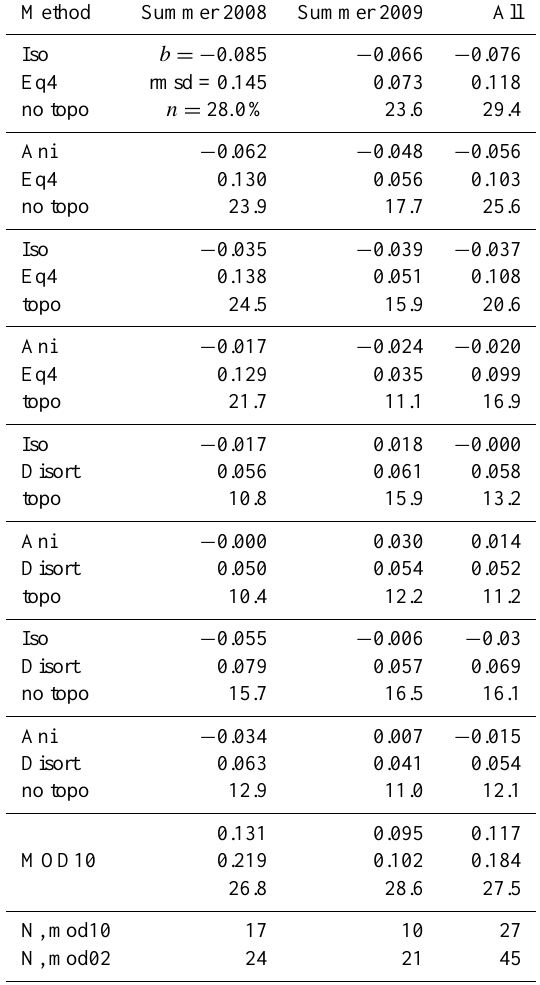
Table 4. Comparison between albedo values retrieved from MODIS and field measured albedo values for summers 2008 and 2009. In the methods, “Iso” means that snow and ice were considered as lambertian, whereas “Ani” means that an anisotropy correction was applied. “topo” vs “no topo” is relative to the correction of the mul- tiples reflections due to surrounding slopes. “Eq4” is relative to the use of Eq. (4) for the narrow-to-broadband conversion, whereas “disort” refers to the method describes in Sect. 3.2.2. The statistics given in this table are b for the mean difference between MODIS albedo values and the measured values, rmsd stands for the root mean square deviation between both values and n is the mean abso- lute relative error in percent. The last two lines of the table indicate the number of pixels used in the statistics for MOD10A1 and for all the other methods based on MOD02. This number is lower for MOD10 since in many cases the glacier pixels were misclassified as land or